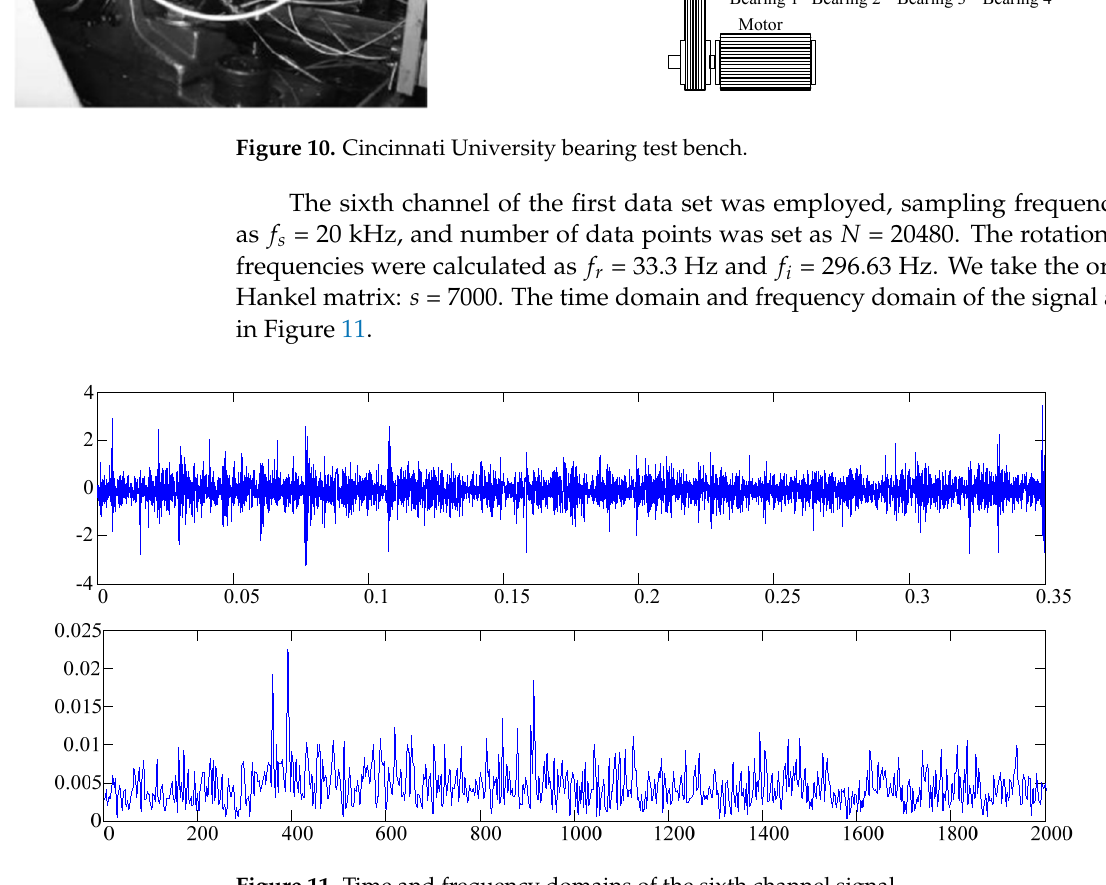
Figure 12. Frequency domains comparison of various algorithms. ( a ) Original signal; ( b ) SVD; ( c ) EMD; ( d ) ADMD-CS. Though the comparison of the three methods in Figure 12 and Table 6, it can be easily found that, though SVD can remove plenty of noise, the low-frequency fault component submerged in the noise was also removed as noise, and only the part of the fault frequency with strong energy was retained. While EMD decomposes the signal into several IMFs,